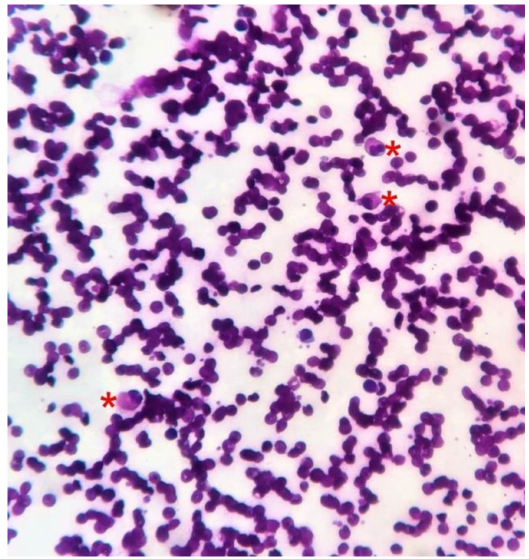
Figure 5. Peripheral smear, multiple eosinophils noted (red *). These suggest a parasitic infestation, in this case,